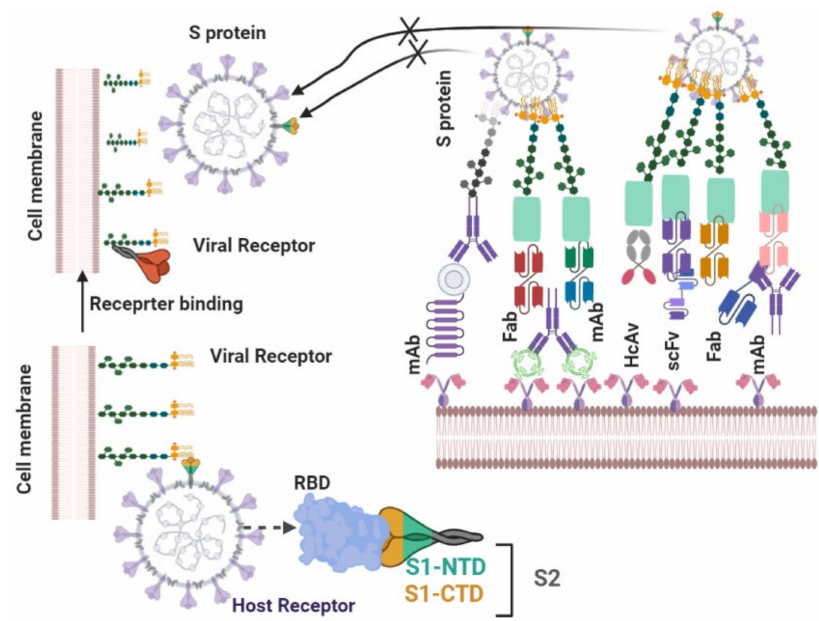
Figure 6. Schematic of binding mechanism of SARS-CoV-2 spike protein to the